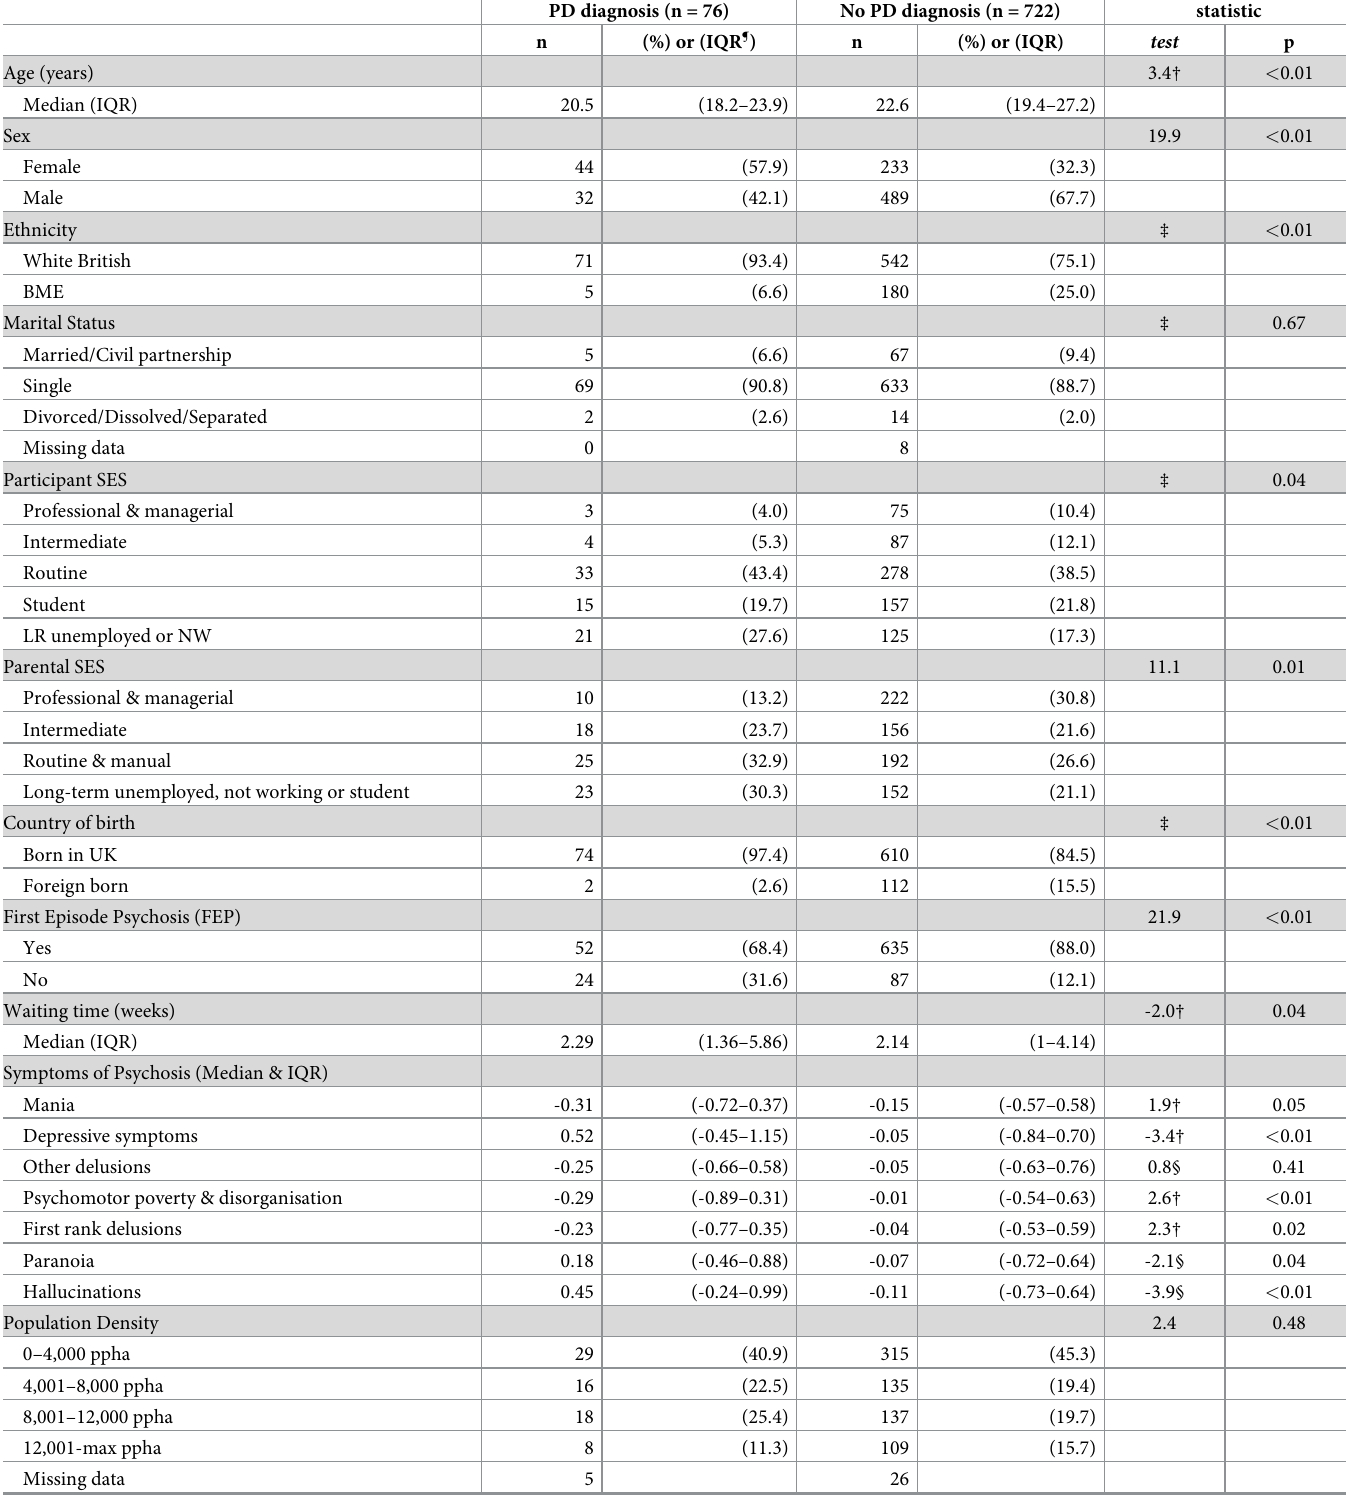
Table 1. Demographic and clinical characteristics of people within EIP